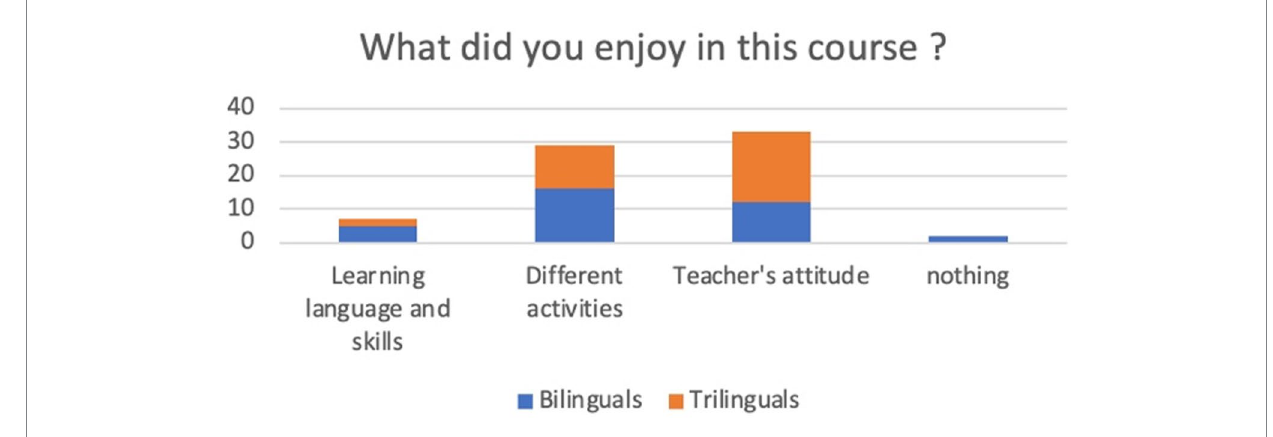
FIGURE 2 Histogram the answers to question 1.